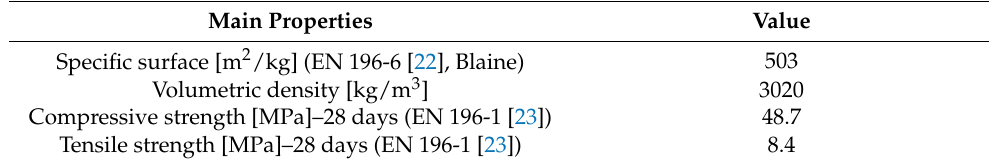
Table 1. Main properties of CEM II/B-M (S-LL) 32.5 R.